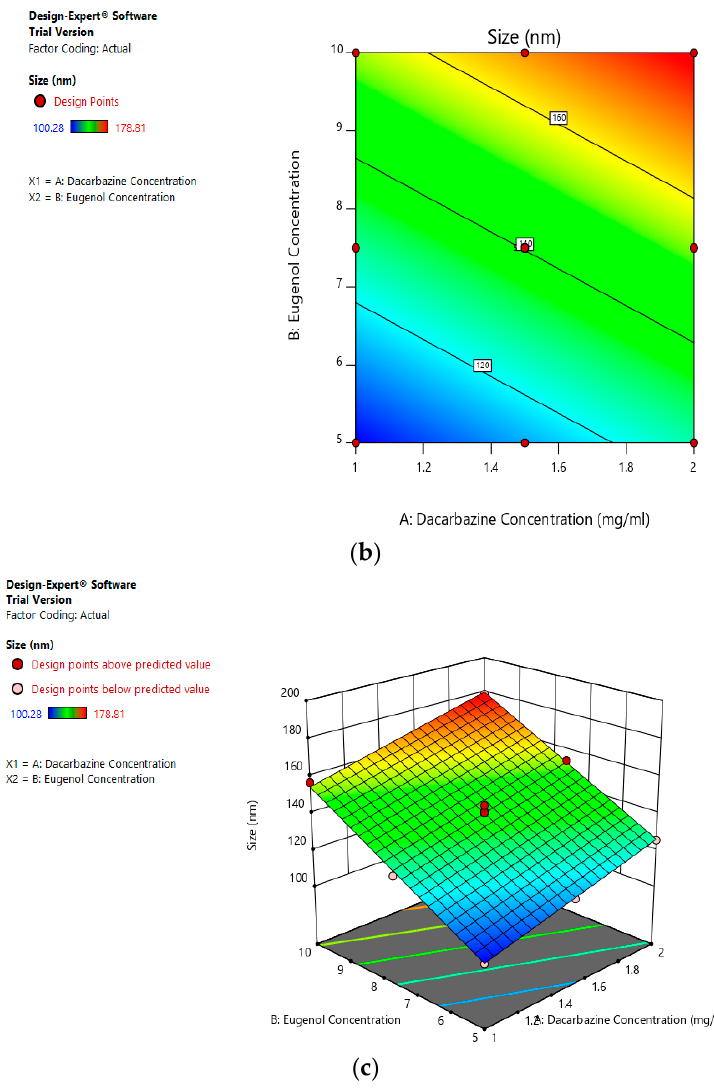
Figure 5. Effect of factors on size of DEL ( a ) Effect of individual factors on the size of dual loaded liposomes; ( b ) Effect of the combination of two factors on the size of dual loaded liposomes (2D plot); ( c ) Effect of the combination of two factors on the size of dual loaded liposomes (3D plot). Eugenol:Dacarbazine was constrained at maximum. On fitting the response values to various models, the data was best explained with the quadratic model (Table 2). Values of Model F -value, Lack of fit F -value and p -value were also favorable (Table 2). Equation (8) represents the effect of independent variables on the size of the final liposomes.